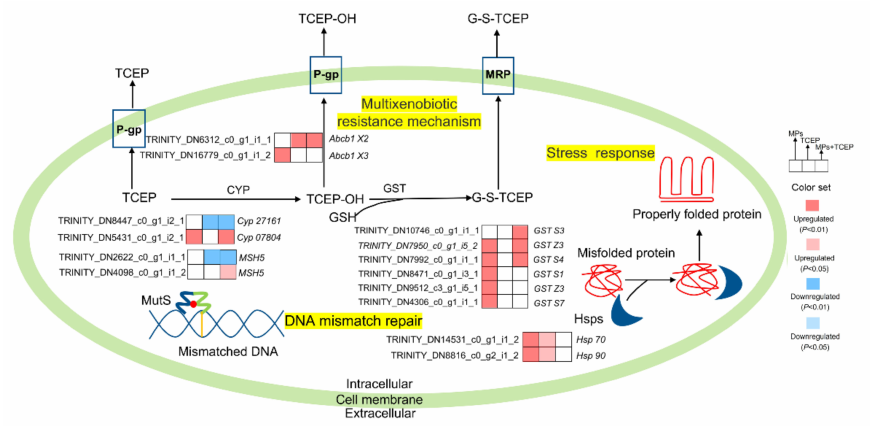
Figure 8. Overview of transcriptional changes in gene that matched to Brachionus when rotifers were co-exposed to MPs and TCEP. Each index comprises the changes in gene transcriptions in different exposure groups (MPs, TCEP, and MPs + TCEP) relative to the control group. The red or blue color scale indicates gene transcripts shown to be up- or downregulated,